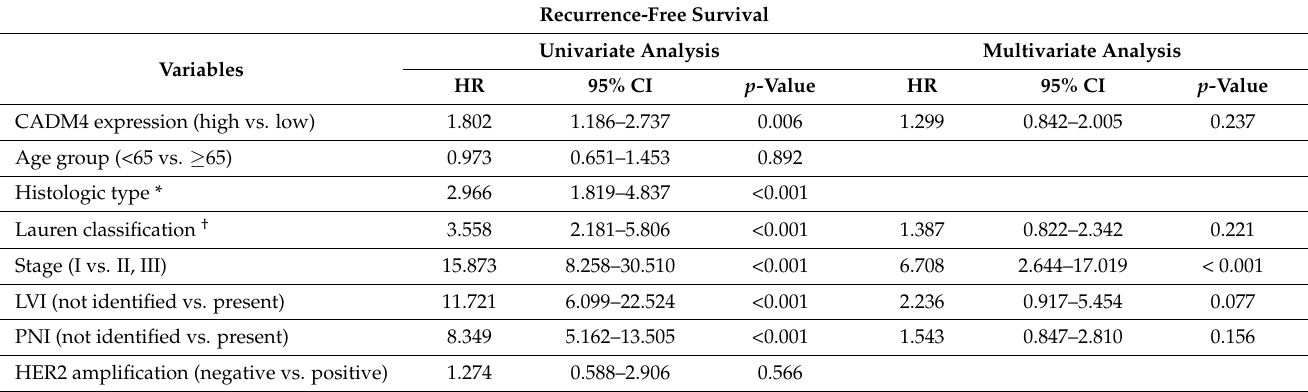
Figure 2. Kaplan–Meier analyses for overall survival ( a ) and recurrence-free survival ( b ). Overall survival and recurrence-free survival were significantly worse in patients with low CADM4 expres- sion (Log-rank test, p = 0.007 and p = 0.005, respectively).